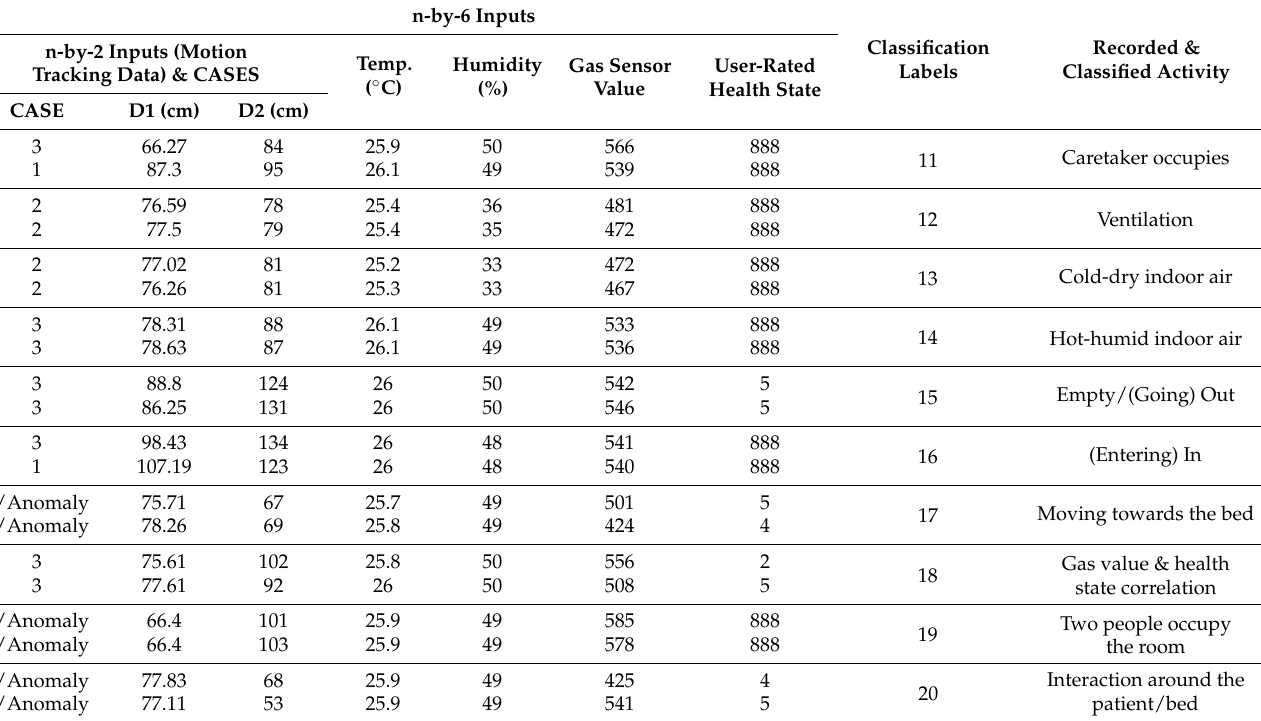
Table 7. Examples from the initially recorded dataset with classified user activities. n-by-6 Inputs